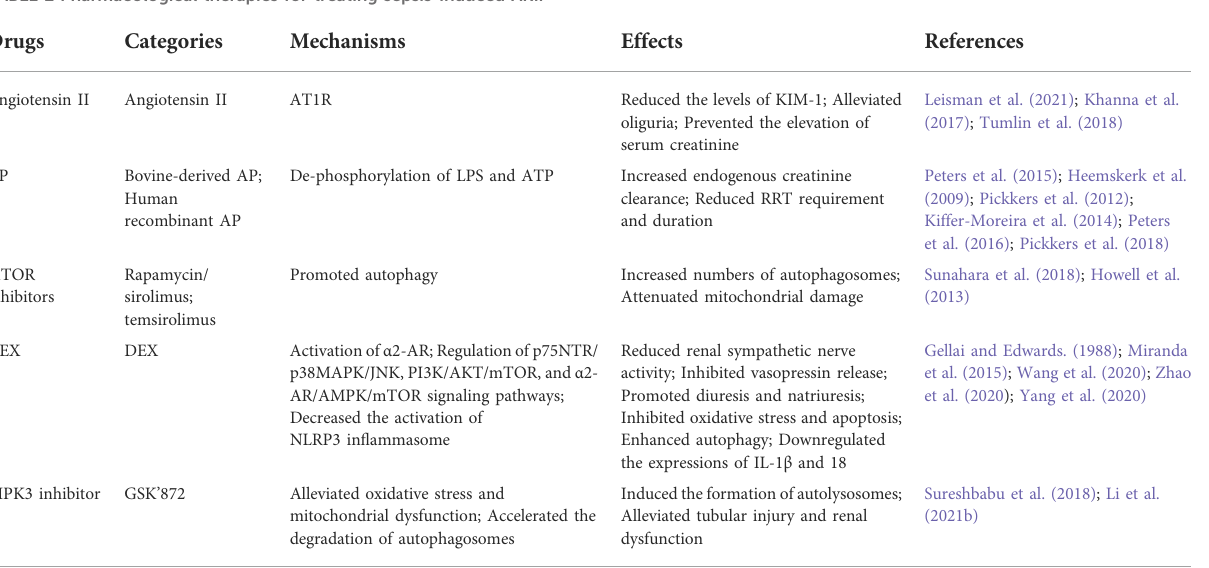
TABLE 2 Pharmacological therapies for treating sepsis-induced